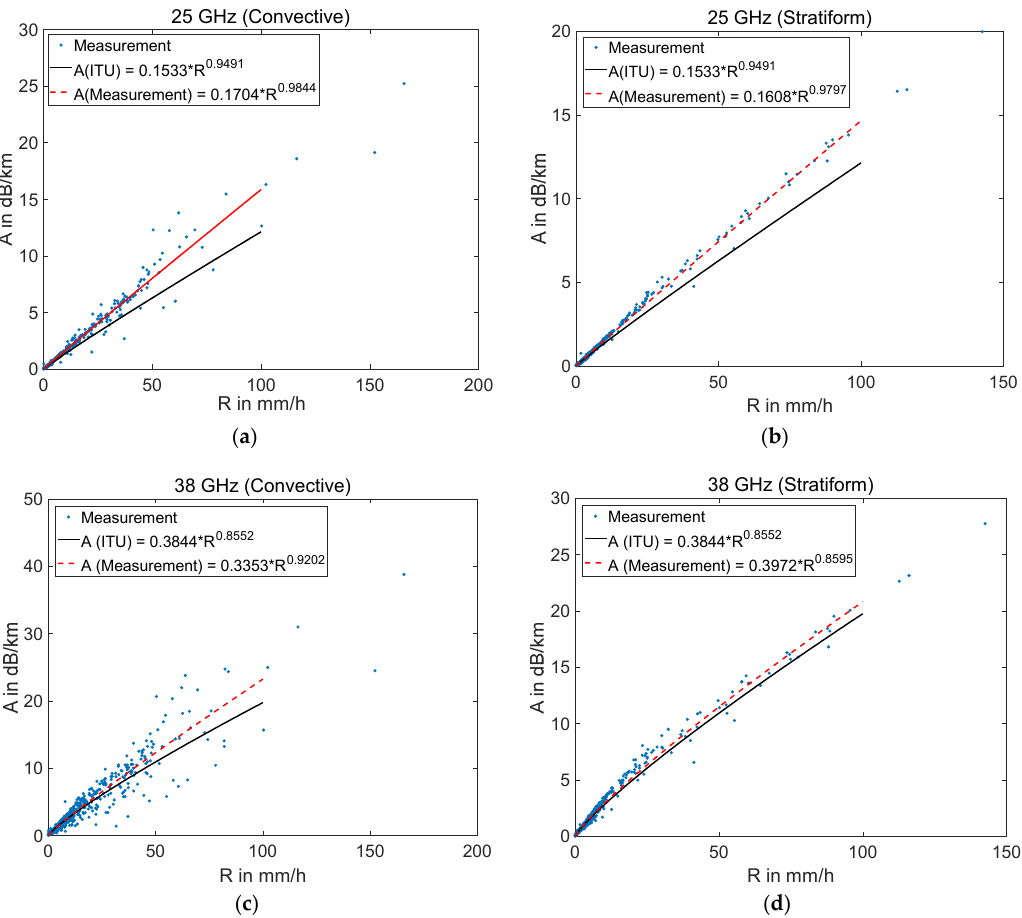
Figure 4. The relation between the rainfall rate R and attenuation A for ( a ) a 25 GHz link in convective precipitation ( b ) a 25 GHz link in stratiform precipitation ( c ) a 38 GHz link in convective precipitation ( d ) a 38 GHz link in stratiform precipitation.